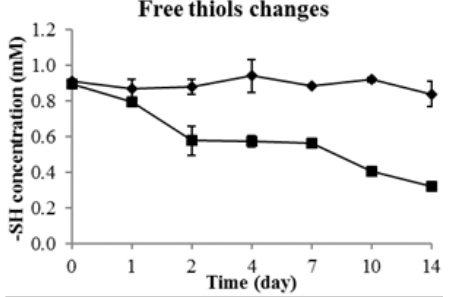
Figure 2. Kinetic changes of free thiols (determined by the 5,5′-dithiobis(2-nitrobenzoic acid), DTNB method) concentration during durian wine fermentation and in durian pulp control; durian wine fermentation ( ■ ), durian pulp control ( ◆ ).